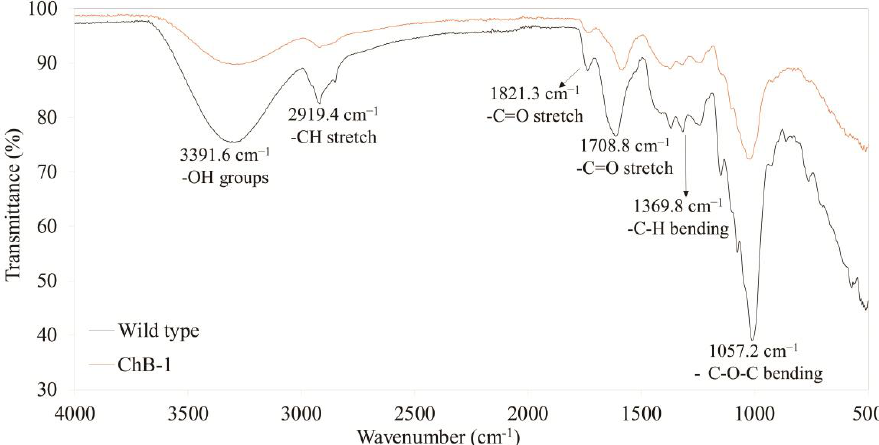
Figure 6. Fourier-transform infrared (FT-IR) spectra of biomass obtained from the wild-type and transgenic tobacco plants overexpressing T. maritima BglB targeted to the chloroplasts (ChB-1 line). Wild-type: black line, transgenic: red line.